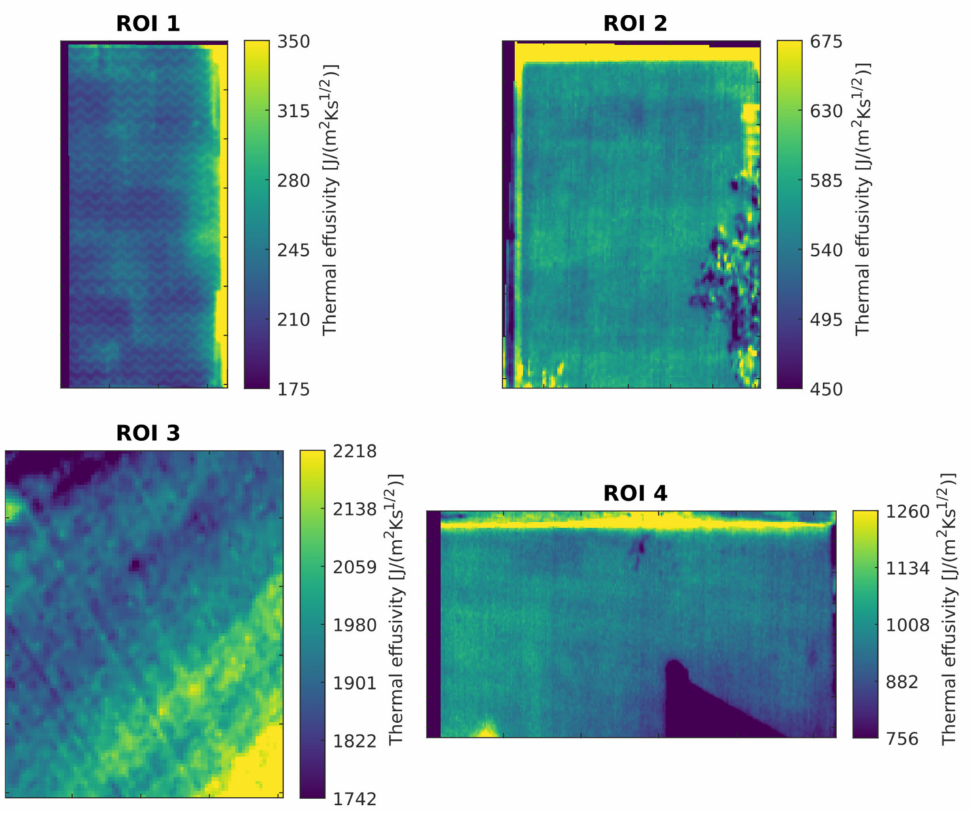
Figure 10. Perspective- and albedo-corrected SHT effusivity images.